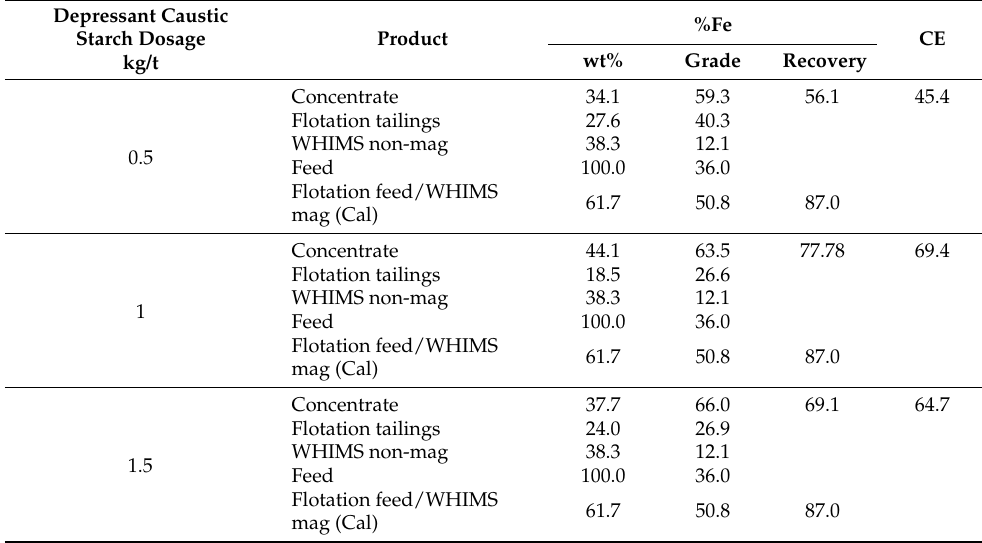
Table 7. Effects of depressant dosage on reverse flotation of WHIMS concentrate.